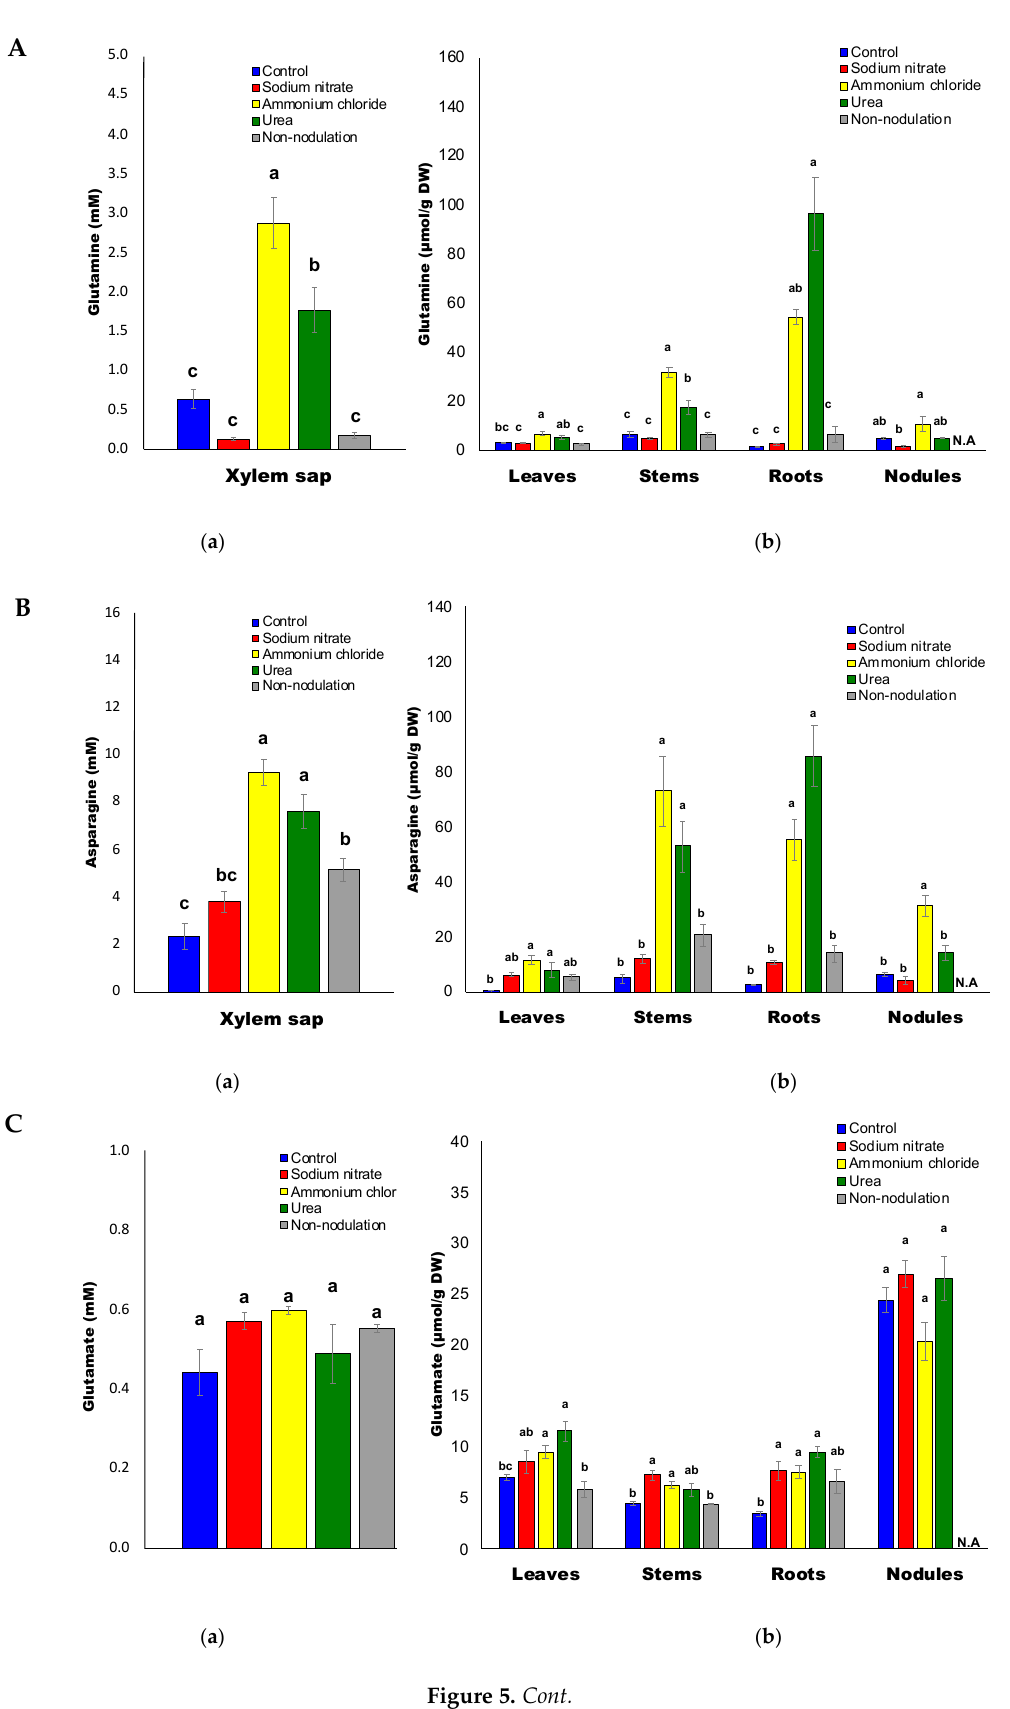
( b ) Figure 4. ( A ) Ureide concentrations in the xylem sap ( a ) and in each part ( b ) of the soybean plant. ( B ) Urea concentrations in the xylem sap ( a ) and in each part ( b ) of the soybean plant. The average Gln concentration in the xylem sap was about 0.2–3 mM (Figure 5A(a)). The application of ammonium (2.9 mM) and urea (1.8 mM) significantly increased the Gln concentrations in the xylem sap compared to the control (0.68 mM). On the other hand, the xylem sap from the nitrate treated (0.13 mM) and non-nodulated plants (0.18 mM) had decreased Gln concentrations at low levels. The glutamine concentrations were similar between the nitrate and control treatments for the leaves, stems, and roots, but varied in the nodules for the control (4.9 μ mol/g DW) and nitrate (1.5 μ mol/g DW) treatments (Fig- ure 5A(b)). The glutamine concentrations in the leaves, stems, roots, and nodules after the ammonium treatment were much higher than those of the control plants. The glutamine concentrations in the stems and roots (96 μ mol/g DW) subjected to the urea treatment were markedly higher than those of the control. The glutamine concentrations in the non- nodulated plants were similar to the control for all the organs.